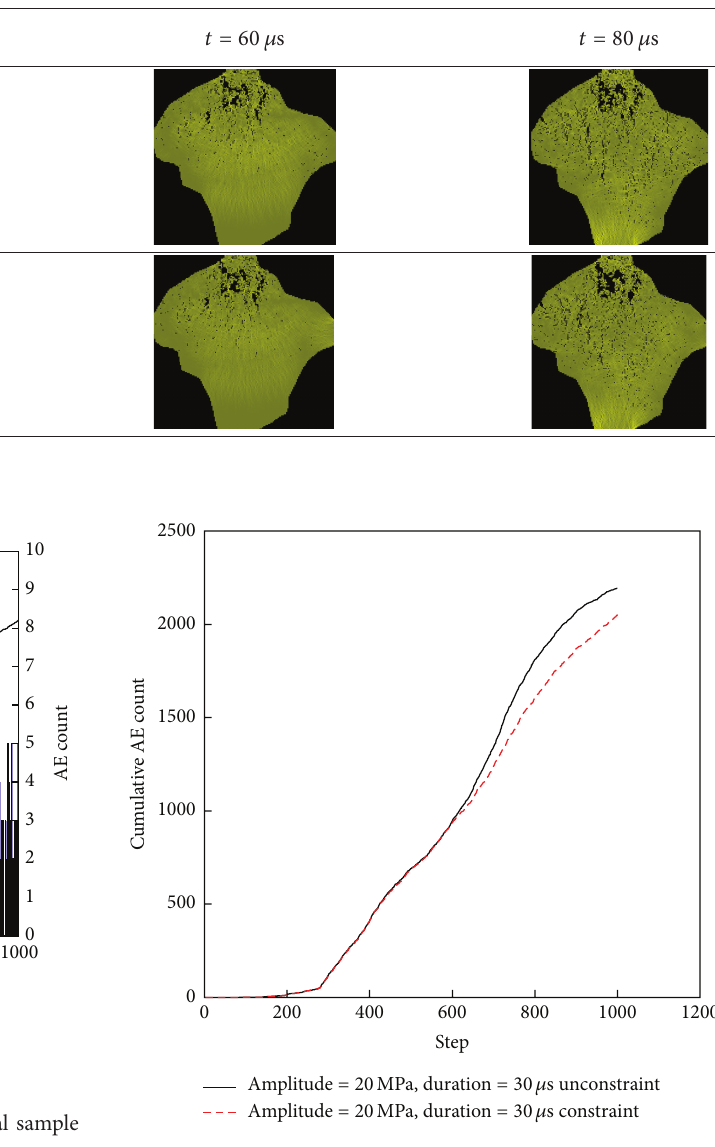
Figure 14: The accumulated counts of damaged elements of sample with unconstraint and